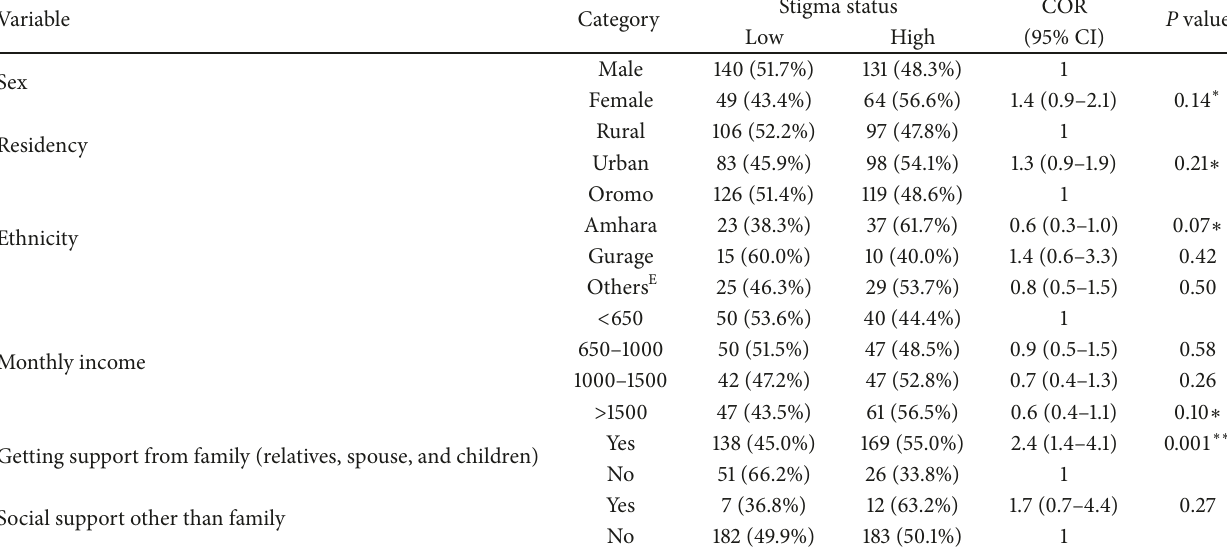
Table 3: Association of sociodemographic and economic factors with perceived stigma in bivariate analysis among adults with mental illness in JUSH, 2012.